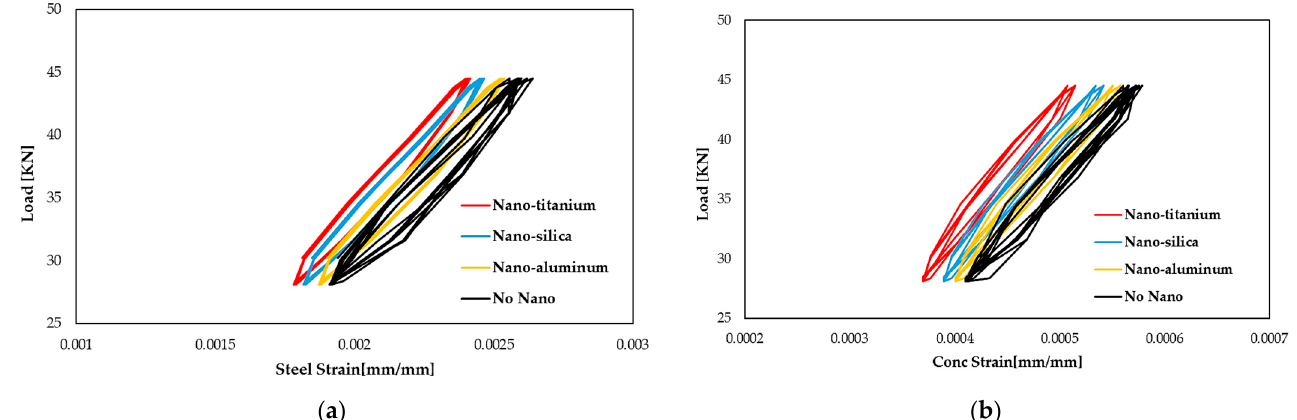
Figure 9. Load ‐ strain curves for all tested beams: ( a ) load ‐ tensile steel strain, and ( b ) load ‐ compres ‐ Figure 9. Load-strain curves for all tested beams: ( a ) load-tensile steel strain, and ( b ) load-compressive sive concrete strain. concrete strain.